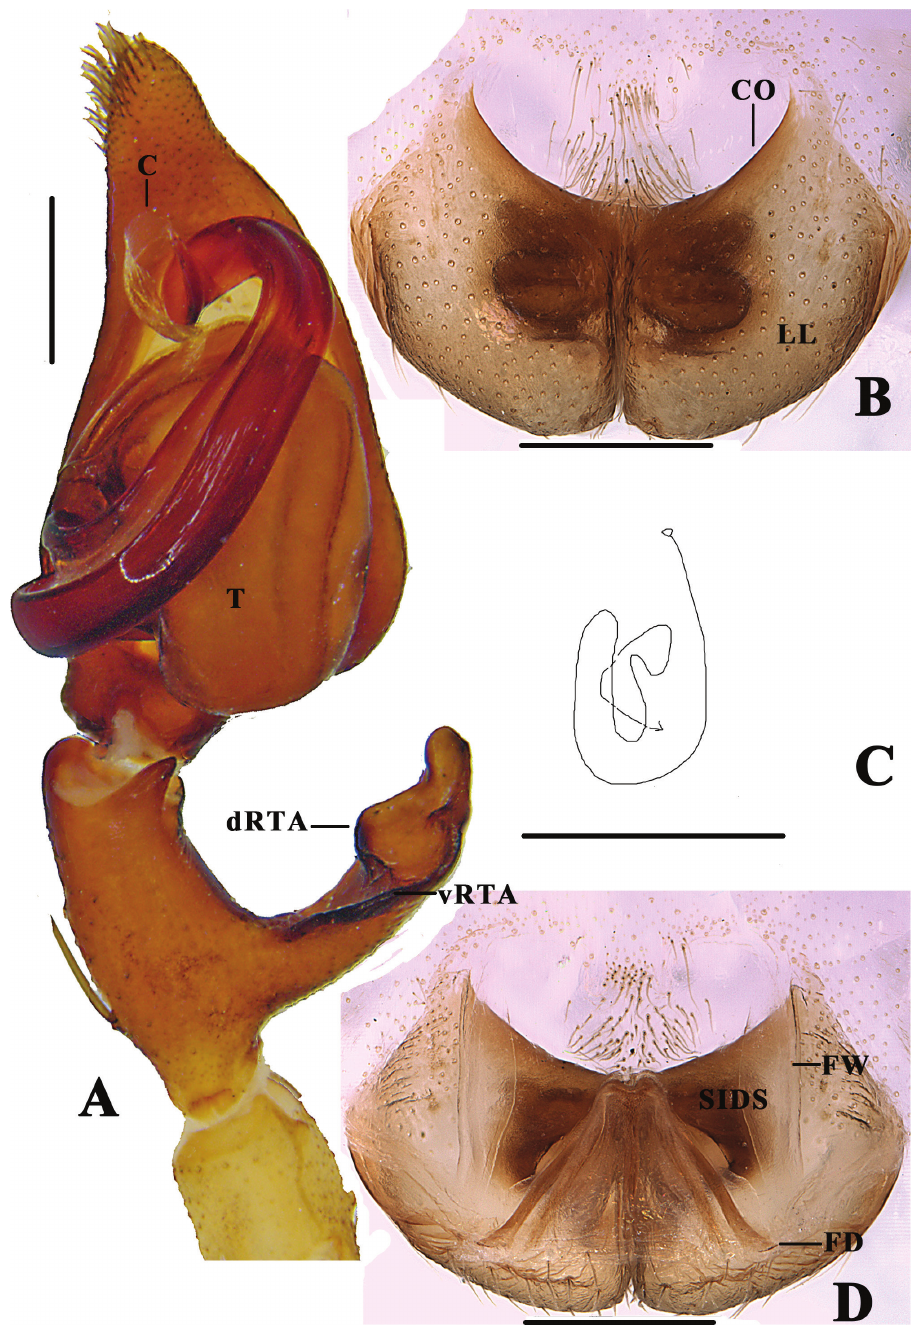
Figure 8. Pseudopoda semilunata sp. nov. A left male palp, ventral B epigyne, ventral C schematic course of internal duct system in right art, dorsal D vulva, dorsal. Abbreviations: C–conductor; dRTA–dorsal retrolateral tibial apophysis; T–tegulum; vRTA–ventral retrolateral tibial apophysis; CO–copulatory opening; LL–lateral lobes; FD–fertilisation duct; FW–first winding; SIDS–sclerotised internal duct system. Scale bars: 0.5